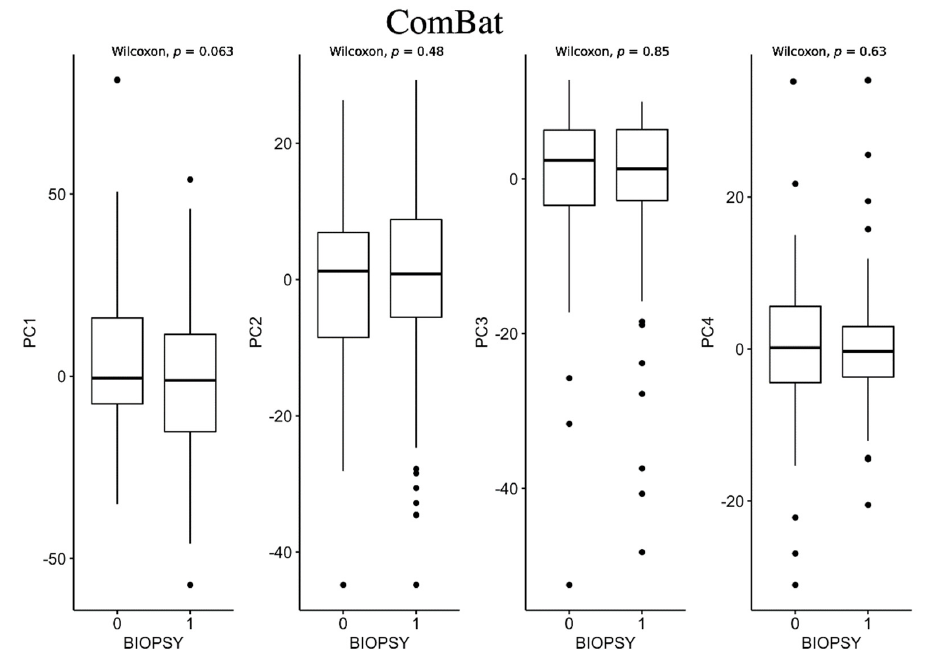
Figure 4. Box plots for ComBat method between negative biopsy (class 0) and positive biopsy (class 1).